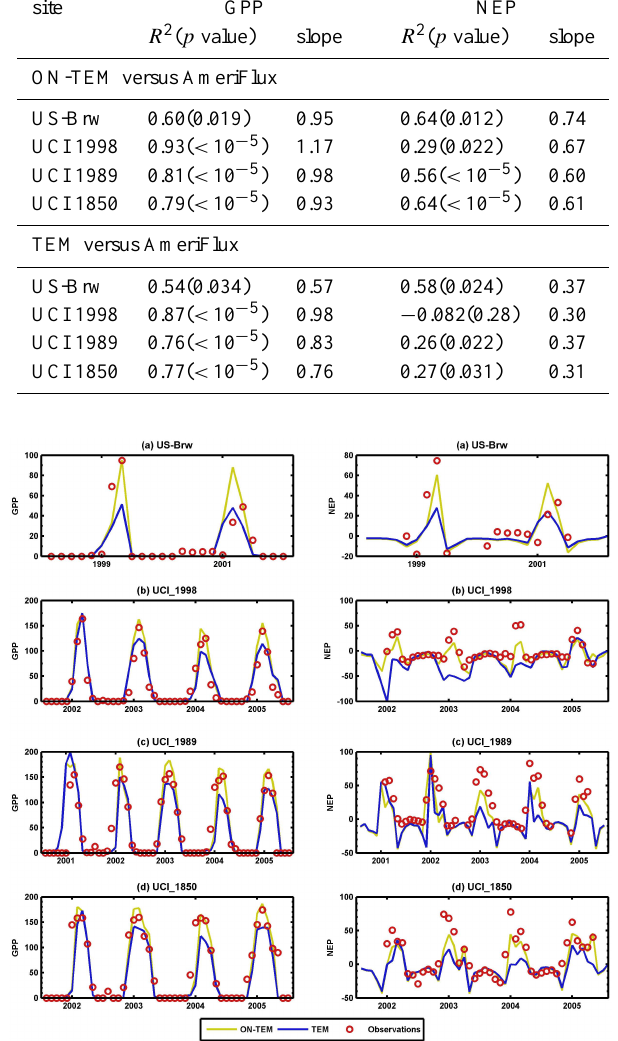
Fig. 3. GPP and NEP (gCm − 2 month − 1 ) simulated by ON-TEM; considerations of the organic nitrogen uptake process are repre- sented by the yellow lines. In comparison with the TEM (blue lines), ON-TEM simulations (yellow lines) are generally more consistent with the observations (red circles). (a–d) are the tundra site US- Brw and the boreal forest sites UCI 1998, UCI 1989 and UCI 1850,